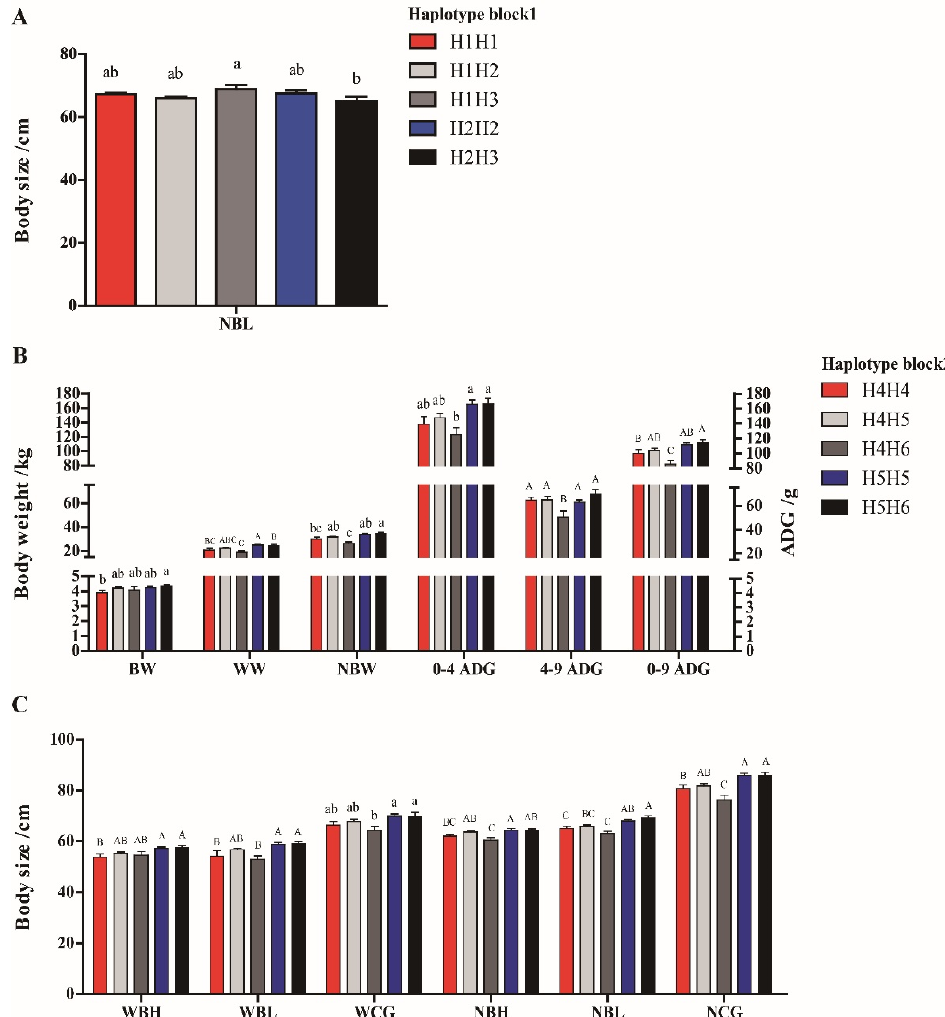
Figure 7. Associations for the haplotype combinations of SNPs in the IGF1R gene with growth traits in Hulun Buir sheep. ( A ) Association analysis for the haplotype combinations (block 1) of the IGF1R gene with growth traits; NBL = body length at 9–months–old. ( B ) The comparison of body weight traits for the haplotype combinations (block 2) of IGF1R gene in Hulun Buir sheep; BW = birth weight; WW = weaning weight (4–month–old); NBW = body weight at 9–months–old; 0–4 ADG = average daily gain from birth to 4–months–old; 4–9 ADG = average daily gain from 4 to 9–months–old; 0–9 ADG = average daily gain from birth to 9–months–old. ( C ) Association analyses for the haplotype combinations (block 2) of IGF1R gene with body size traits in Hulun Buir sheep; WBH = body height at 4 months of age; WBL = body length at 4– months–old; WCG = chest girth at weaning (4–month–old); NBH = body height at 9–months–old; NBL = body length at 9– months–old; NCG = chest girth at 9–months–old. Different letters (small letters: p < 0.05; capital letters: p < 0.01) above the column indicate significant differences among the different haplotype